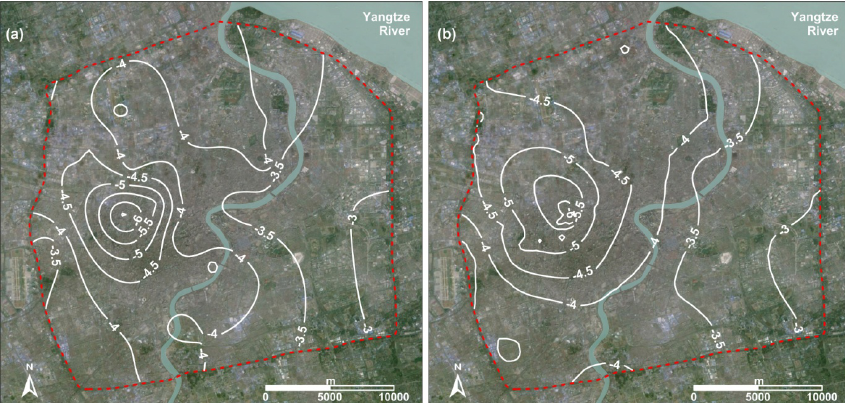
Figure 5. Computed (a) and measured (b) groundwater level in aquifer A2 on 30 December 1995, i.e. at the end of the simulation